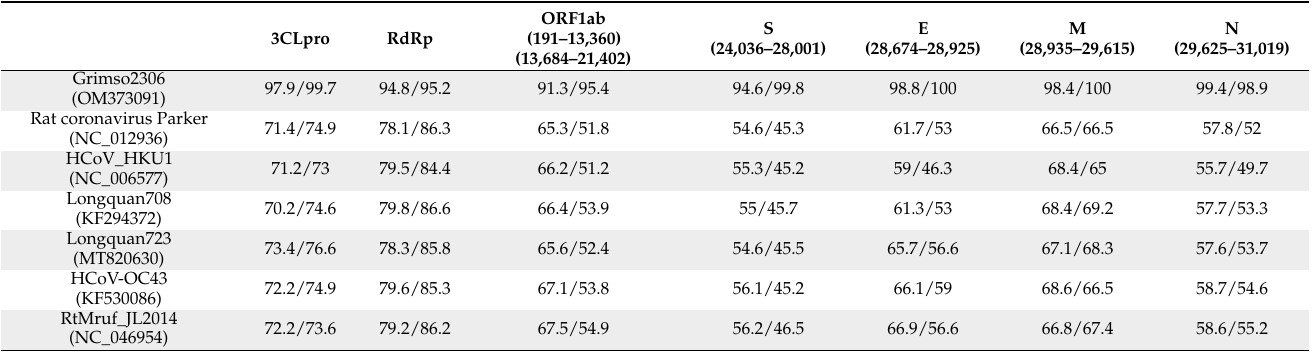
Table 1. Identity (%) of Grimso215 strain on the genes across the genome (at nucleotide/amino acid levels) as compared to the representatives of known rodent